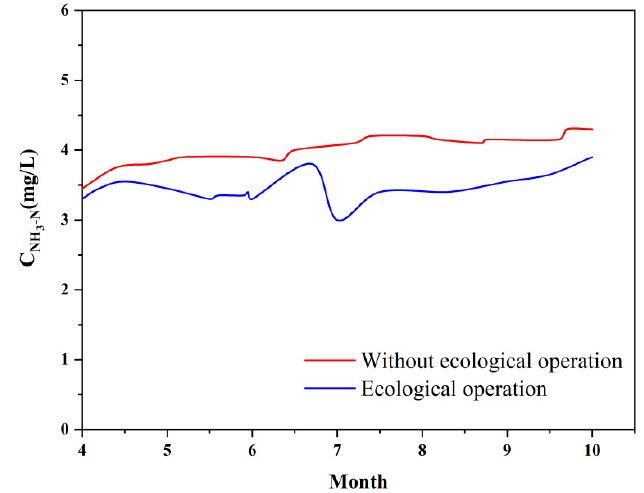
Figure 8. Simulated NH 3 -N concentration before and after the ecological operation scheme.